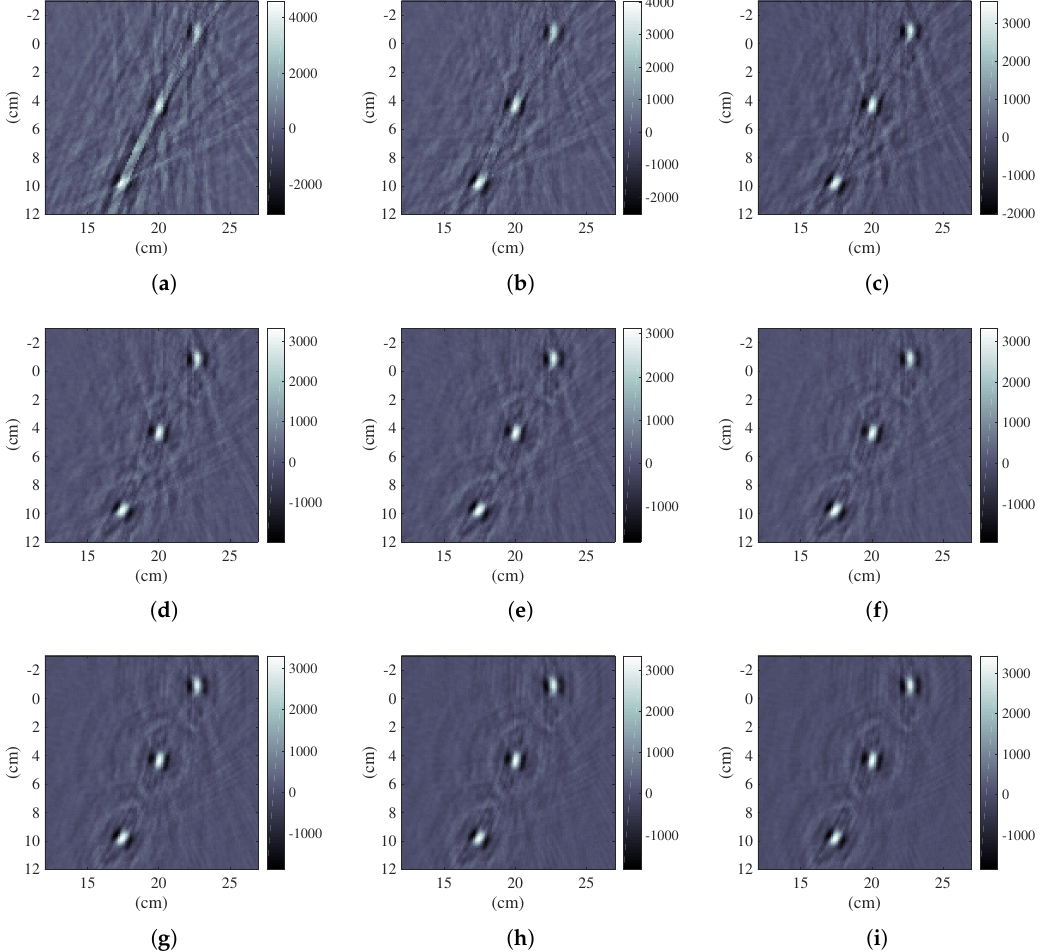
Figure 11. The pin images reconstructed using a number of range profiles: ( a ) 36; ( b ) 72; ( c ) 108; ( d ) 144; ( e ) 180; ( f ) 216; ( g ) 252; ( h ) 288; and ( i )